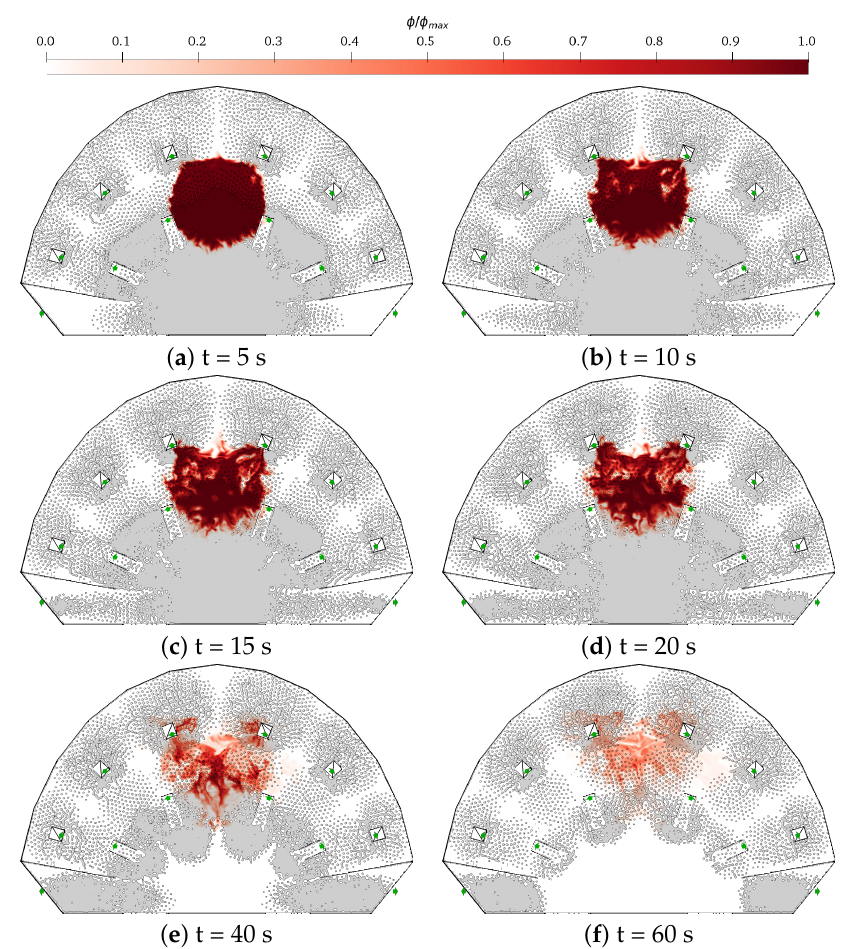
Figure 22. Visualisation of pollutant field at head level at different time step in case of an evacuation of a concert hall (person locations are indicated in